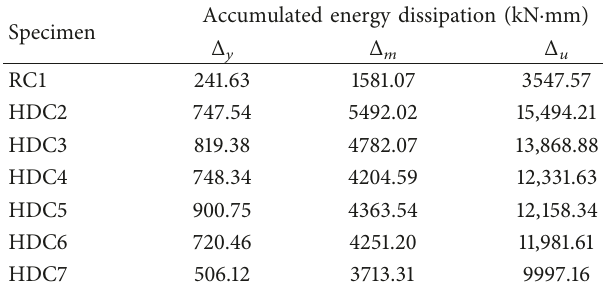
Table 6: Energy dissipation of short